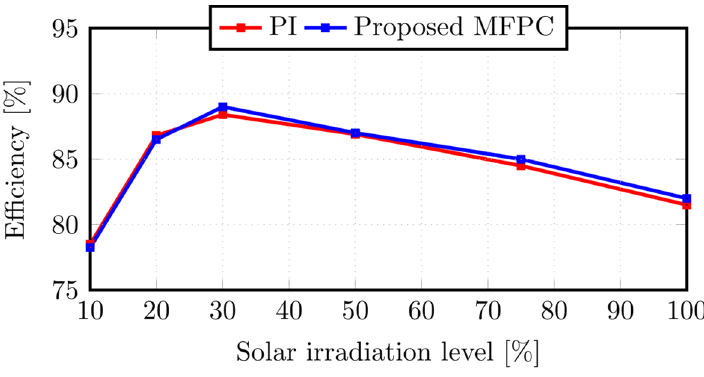
Figure 12. Power loss distribution with the proposed MFPC.